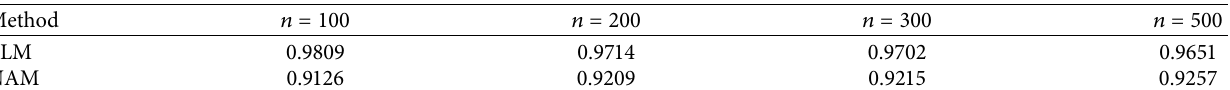
Table 1: Simulation results of Example 1. The coverage probabilities of the confidence regions for ( β respectively.